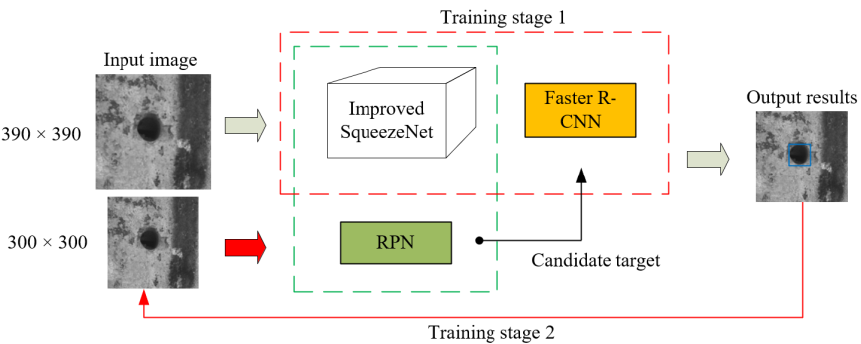
Figure 6. Multi-scale image input of Faster